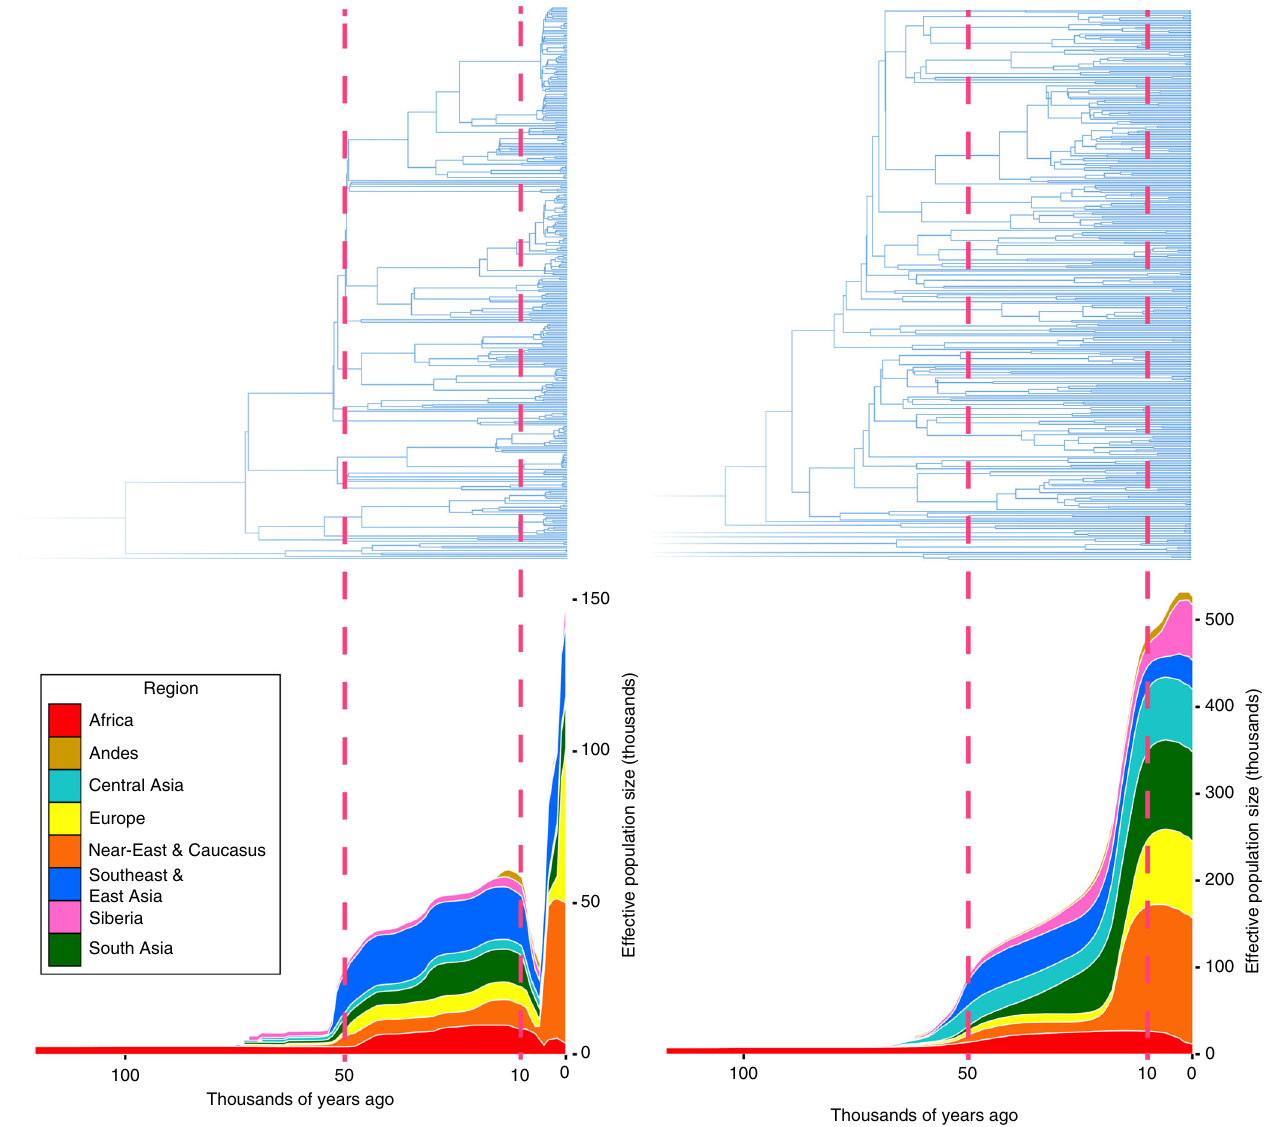
Fig. 1 Cumulative Bayesian skyline plots of Y-chromosome and mtDNA diversity by world regions. Reprinted from Karmin et al. 4 with permission